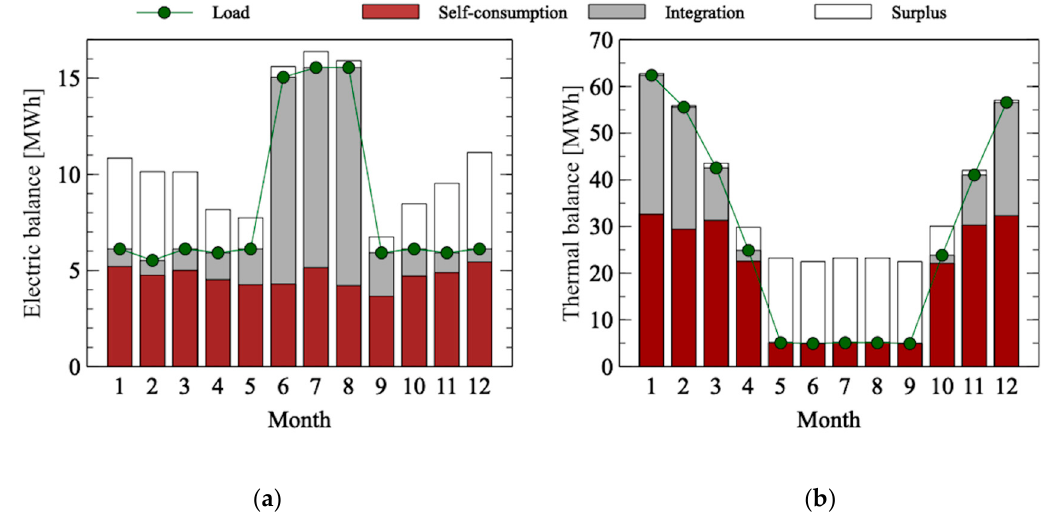
Figure 15. Monthly electric ( a ) and thermal ( b ) balances for the multi/source combined heat and power (CHP) system.